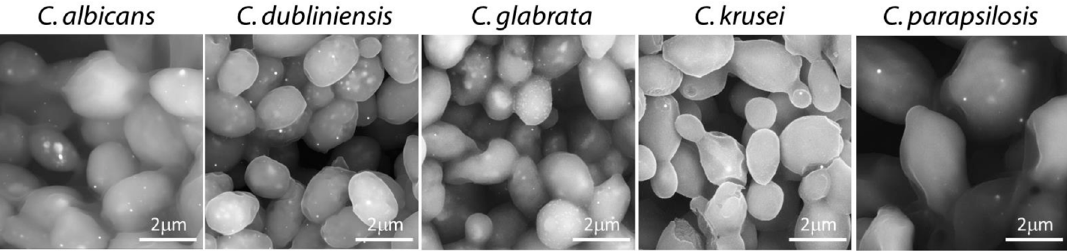
Figure 4. Scanning electron microscopy images of the five Candida strains exposed to the Hg–Cd mixture. Scale bar is indicated in each photomicrograph.